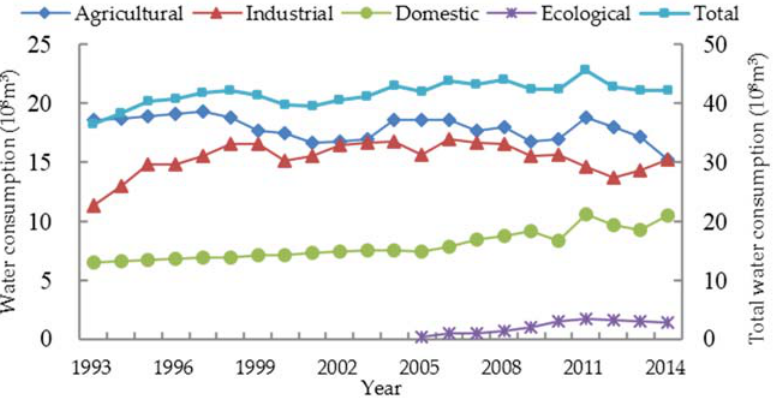
Figure 3. Changes in water consumption by Nanjing city from 1993 to 2014.